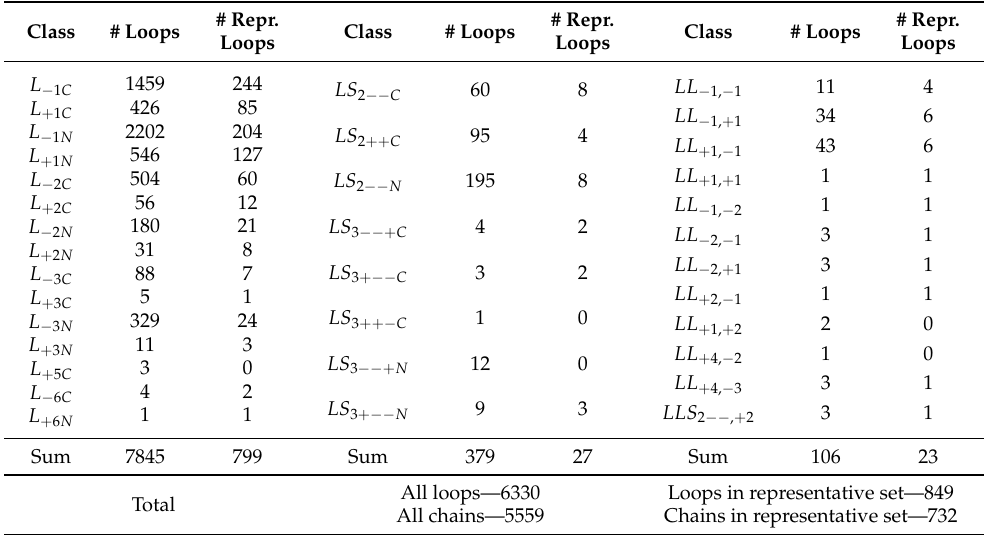
Table 1. Statistics of occurrences of individual loop types—numbers of loops in a given type in all PDB and in the set of non-redundant structures. Note that, in some cases, more than one pierced covalent loop may occur in a given structure (see Lasso fingerprint